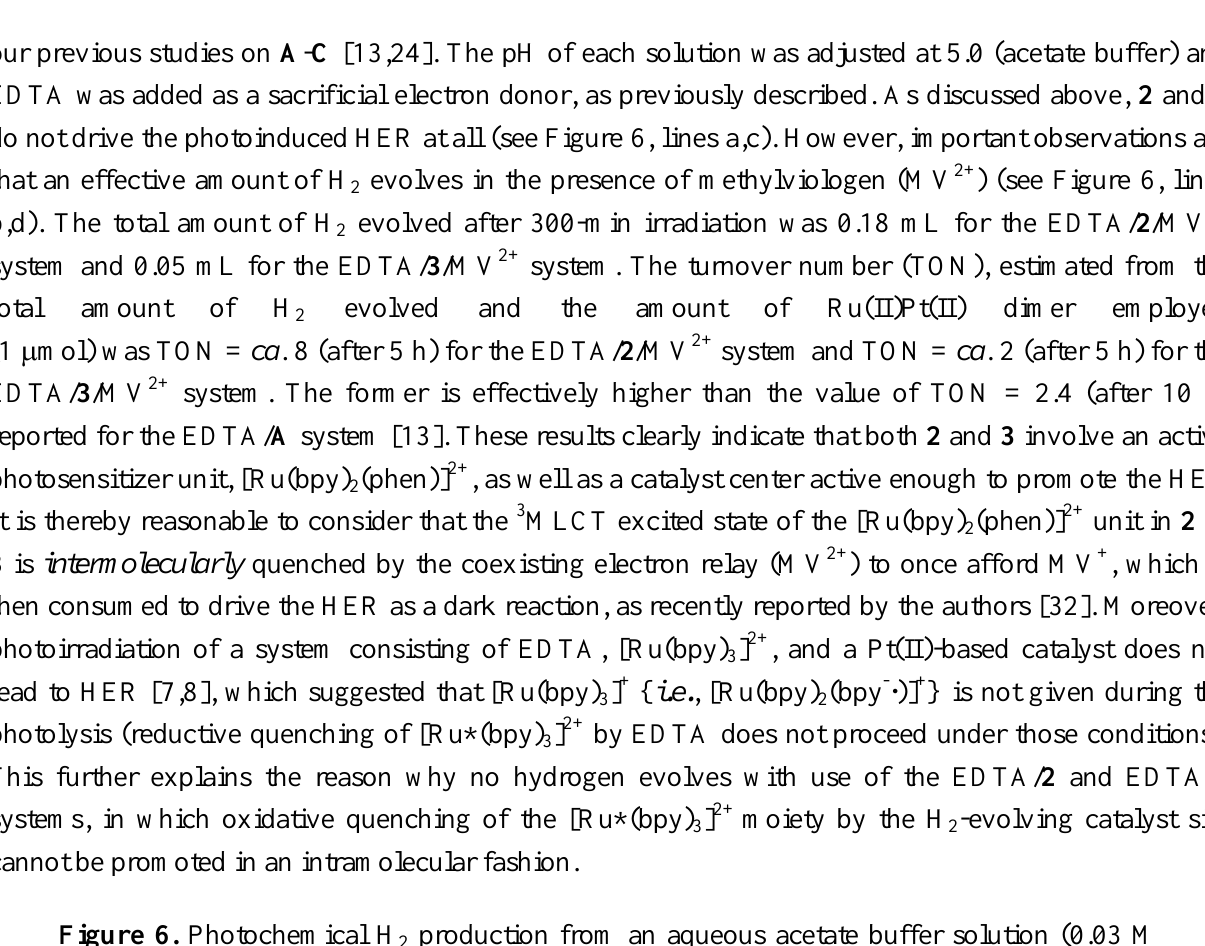
Figure 6. Photochemical H CH CO H, 0.07 M CH 3 2 of (a) 0.1 mM [ 2 ]Cl·6H ) ·2H O, and (d) 0.1 mM [ 3 ](PF [ 3 ](PF 6 2 2